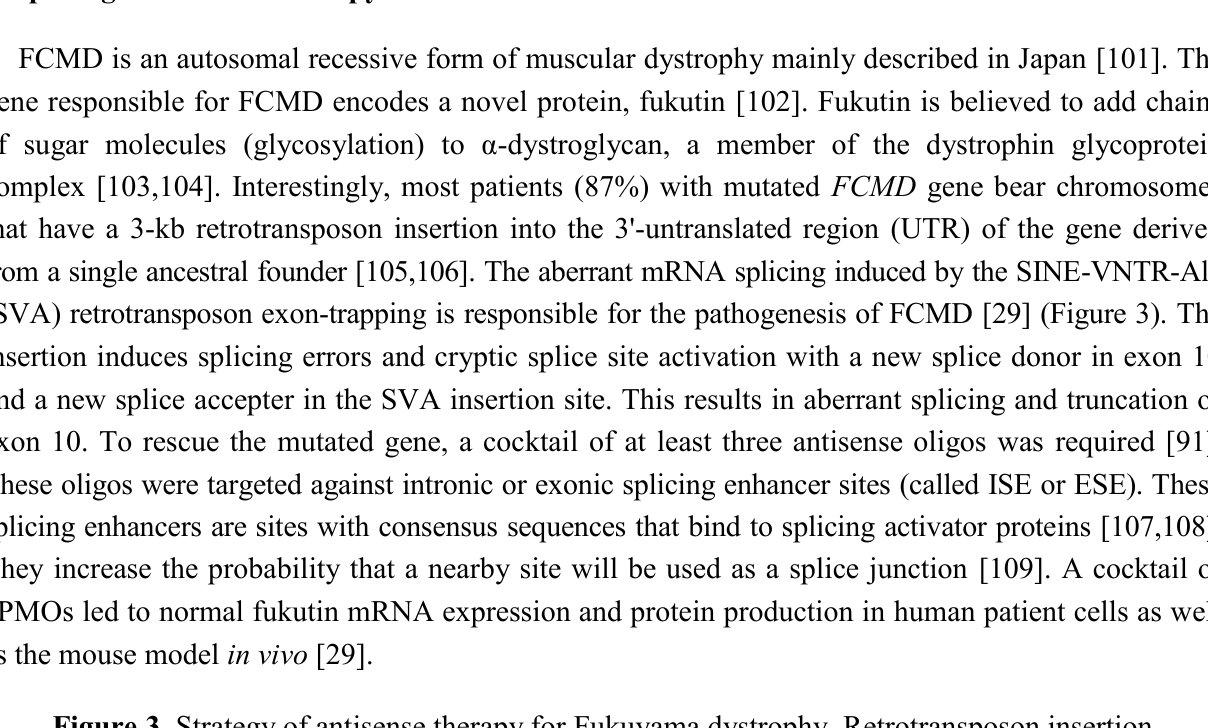
Figure 3. Strategy of antisense therapy for Fukuyama dystrophy. Retrotransposon insertion in the FCMD gene leads to aberrant splicing. An antisense vivo-morpholino cocktail (A3, E3 and D5) restores normal